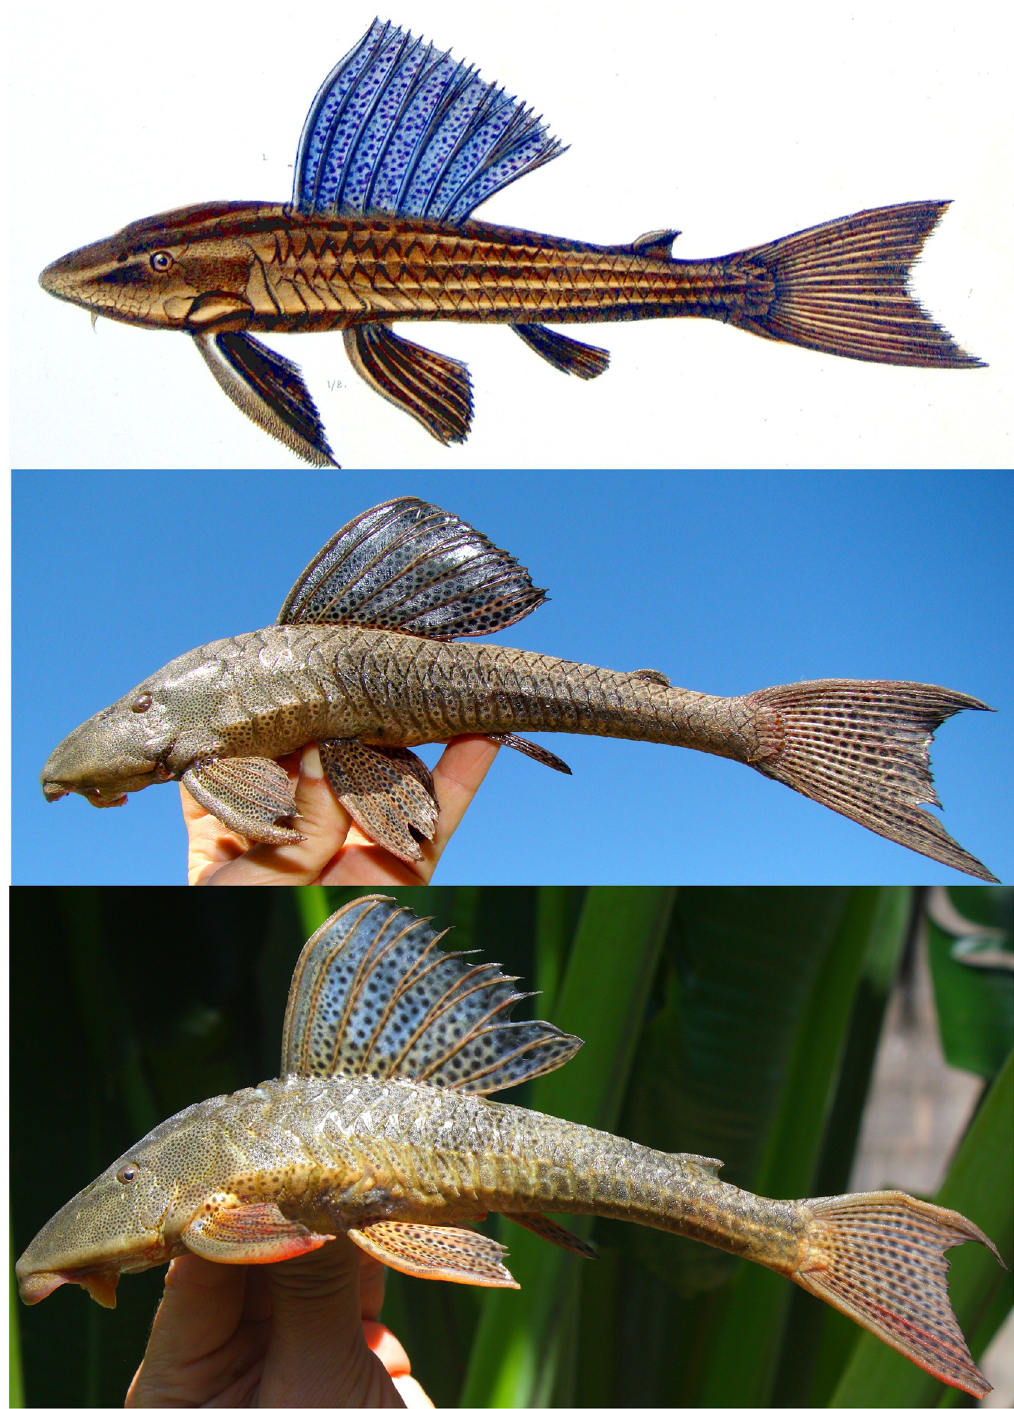
Fig 3. The Castelnau’s (1855) drawing of Hypostomus subcarinatus , MNHN A 9575, 241.8 mm SL, holotype, Brazil, Province de Mines [state of Minas Gerais], is depicted in the upper picture and compared to two live specimens photographed immediately after capture: MCNIP 1761, middle picture 227.2 mm SL and lower picture 196.5 mm SL, both from the Lagoa da Pampulha, Belo Horizonte, Minas Gerais State, Brazil.